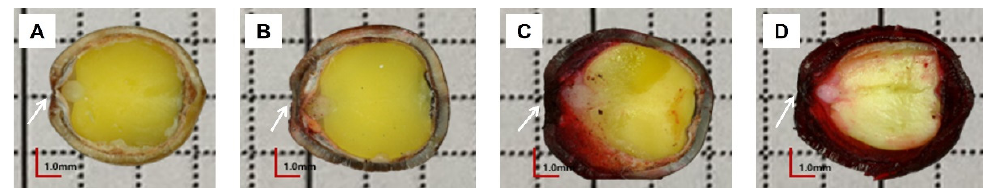
Figure 3. Time periods of water absorption by Hovenia dulcis seeds after sulfuric acid scarification for 1 h at ( A ) 0, ( B ) 1, ( C ) 12, and ( D ) 24 h. Dyeing was performed using safranin stain. Arrows indicate hilar fissure.